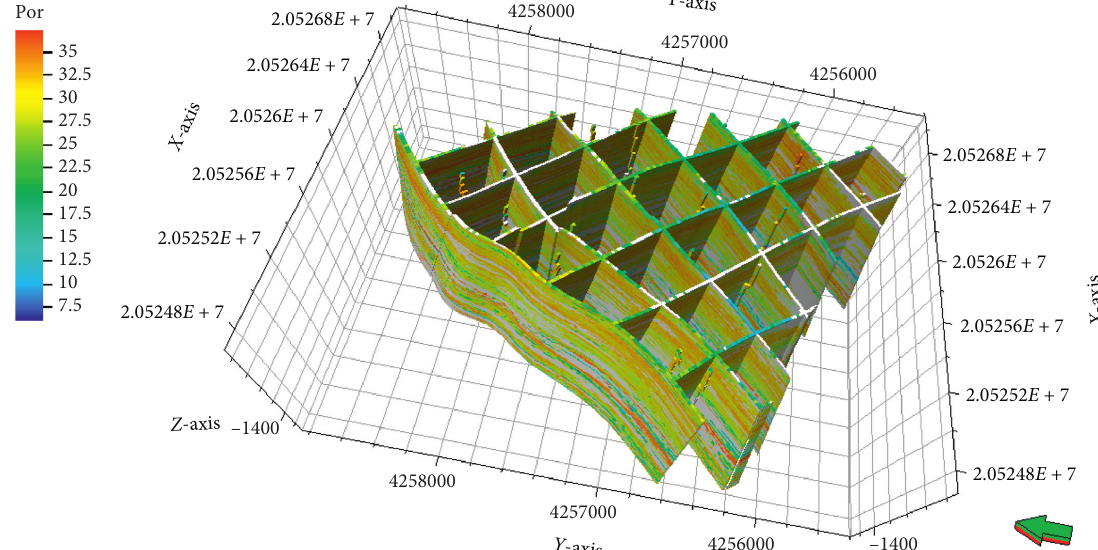
Figure 7: Panoramic display of civil engineering project based on virtual reality